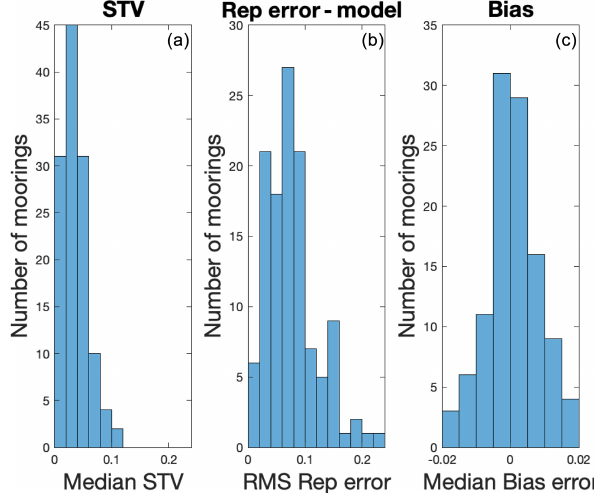
Figure 9. The same as Fig. 5 but for values computed from the MITgcm.